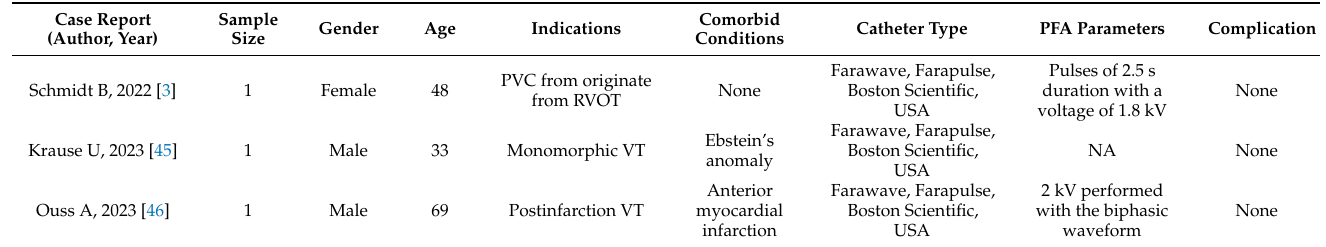
Table 1. Summary of case reports of pulsed field ablation in ventricular